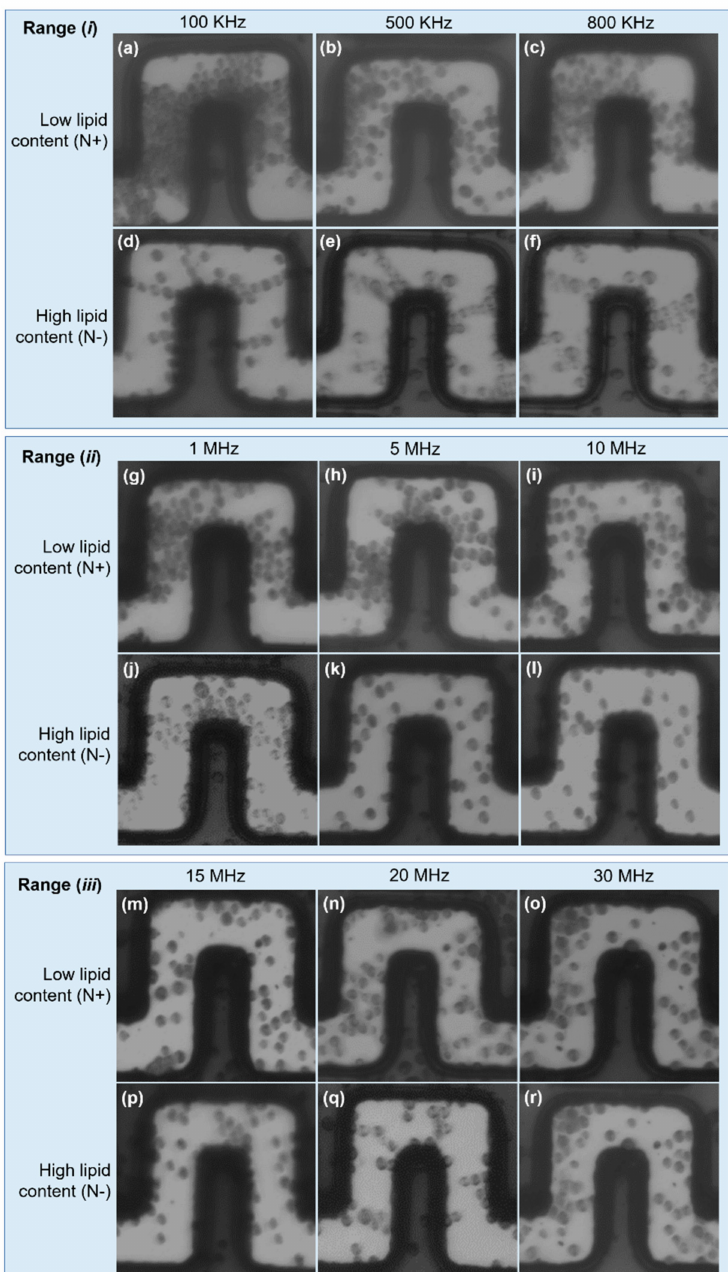
Figure 5. Characterization of HLC and LLC cells. Low frequency range: ( a – f ). A strong pDEP effect is experienced by LLC cells. In contrast, slight pDEP attractions were noticed in HCL cells, demonstrated by pearl chain formations due to weak cells polarization. Mid frequency range: ( g – l ). pDEP is experienced by LLC cells at 1 MHz and 5 MHz, and becomes negligible at 10 MHz. HLC cells show nDEP at 5 and 10 MHz. High frequency range: ( m – r ). Both cell types experience nDEP, which drives the cells to low ∇ ( E · E ) magnitudes. Cell fouling can be appreciated in all